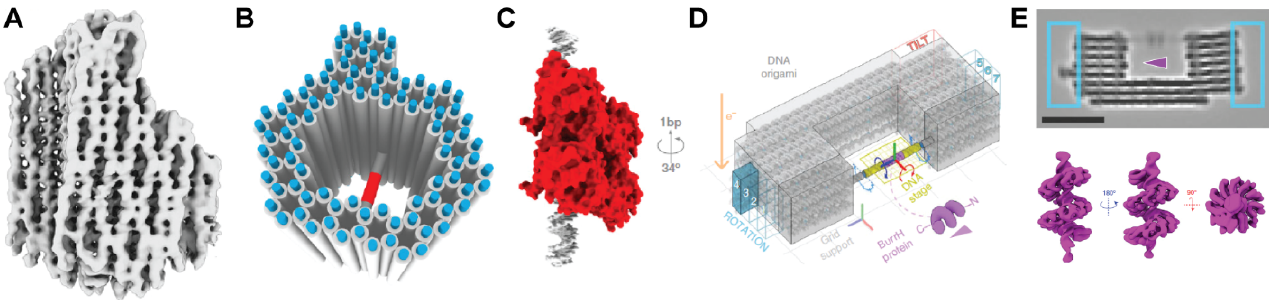
Figure 3. DNA nanostructure analysis by cryo-electron microscopy. ( A ) Structure of an asymmetric DNA origami “pointer” object at 9–14 Å resolution [21]. ( B ) DNA origami “frame” with a spanning helix for binding the transcription factor p. 53 [15]. ( C ) The orientation of the protein on the spanning duplex can be tuned by the relative positioning (and thus rotation) of the binding site on the helix. ( D ) Design of a 3D origami with a spanning helix, and several “bits” to determine the orientation, for binding the protein BurrH. Reprinted with permission from ref. [16], Copyright 2020 Springer Nature. ( E ) Cryo-EM image of the structure ( top ) with encoding bits boxed in blue; 3D reconstruction of BurrH ( bottom ).